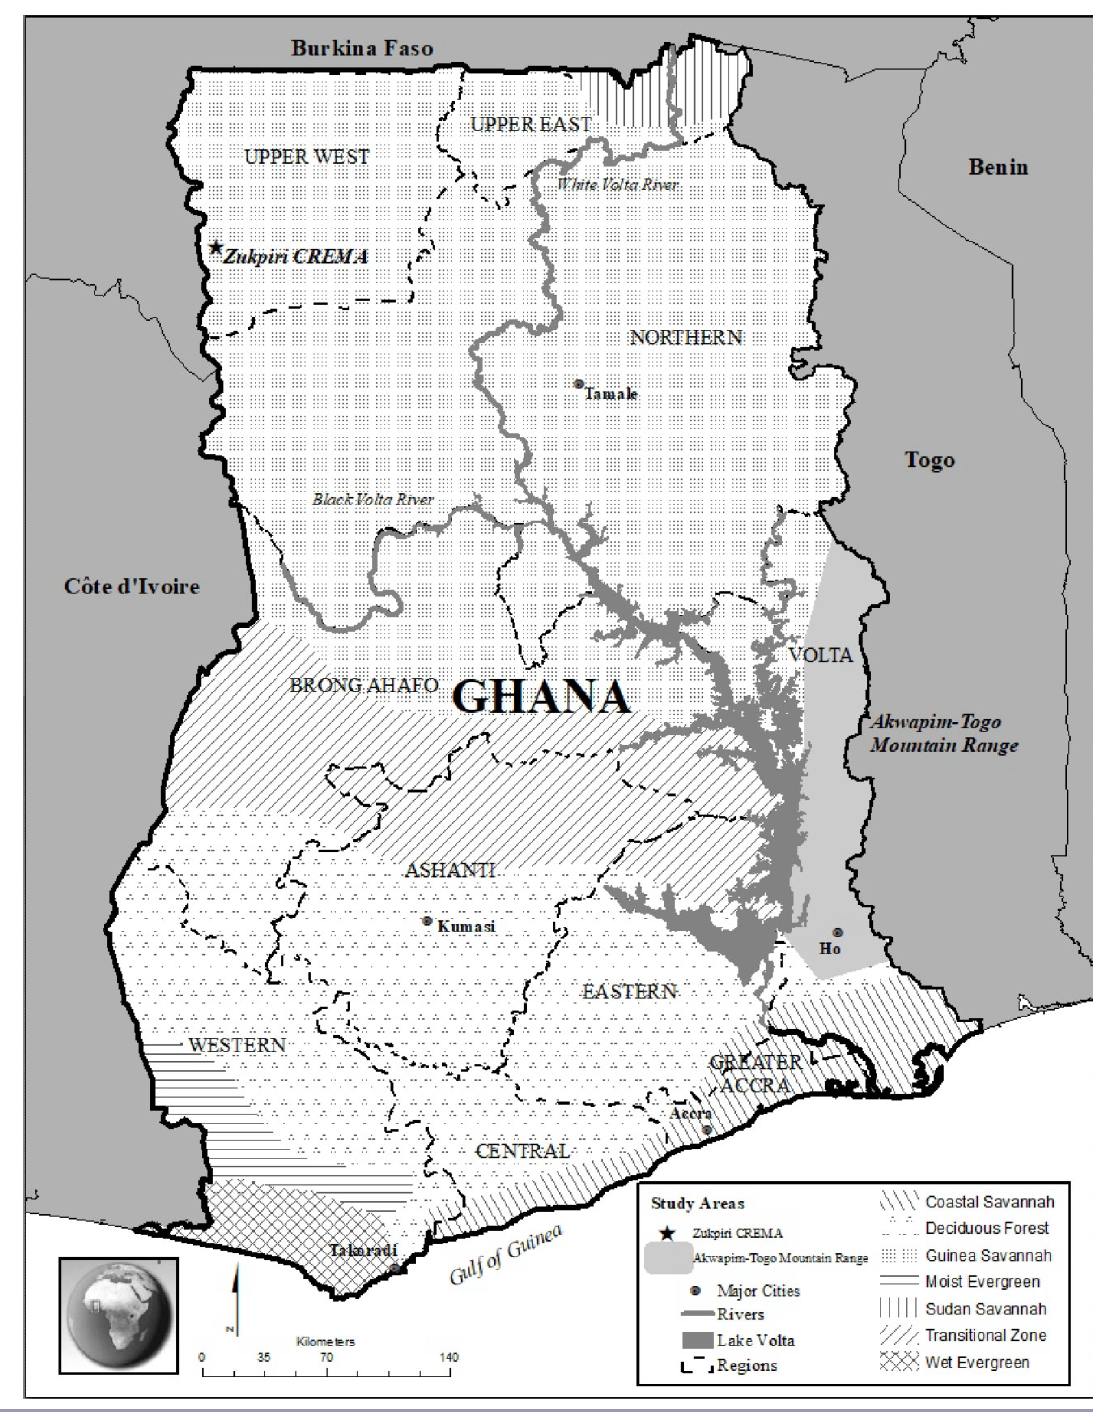
Fig. 1 . Study area